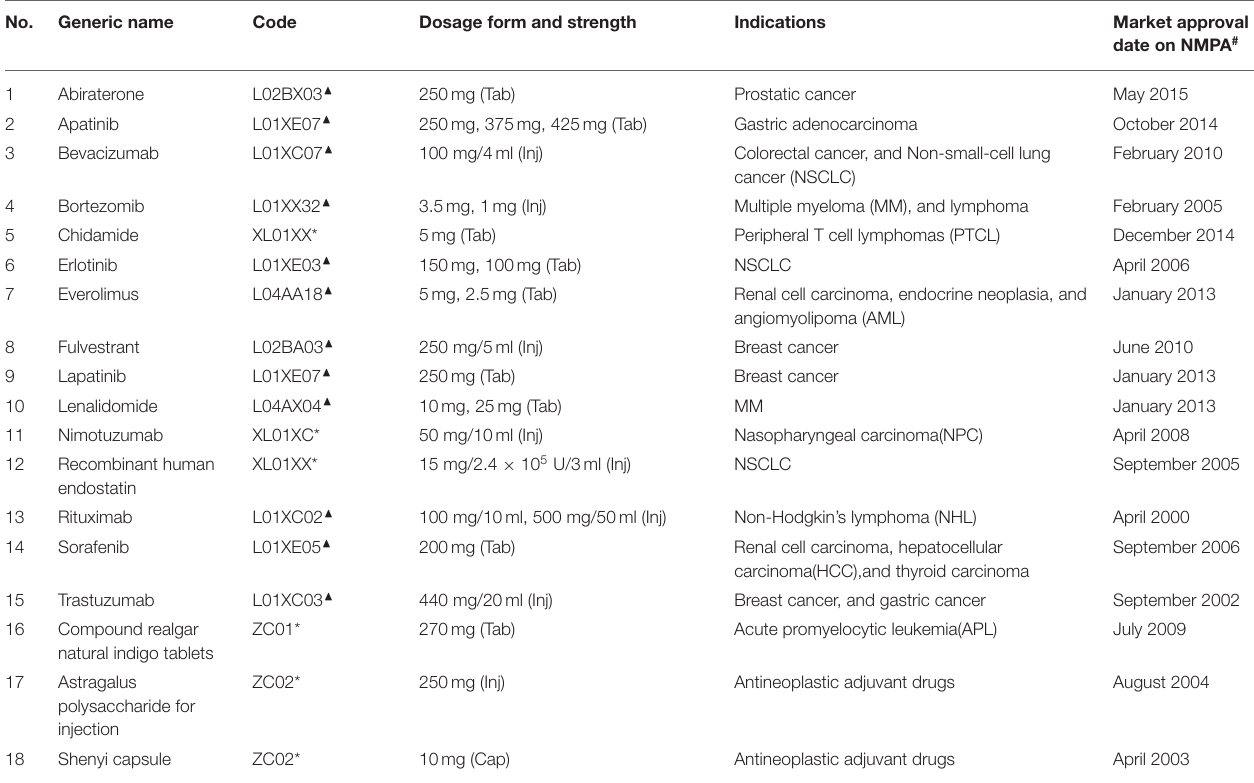
TABLE 1 | Characteristics of 18 investigated anticancer